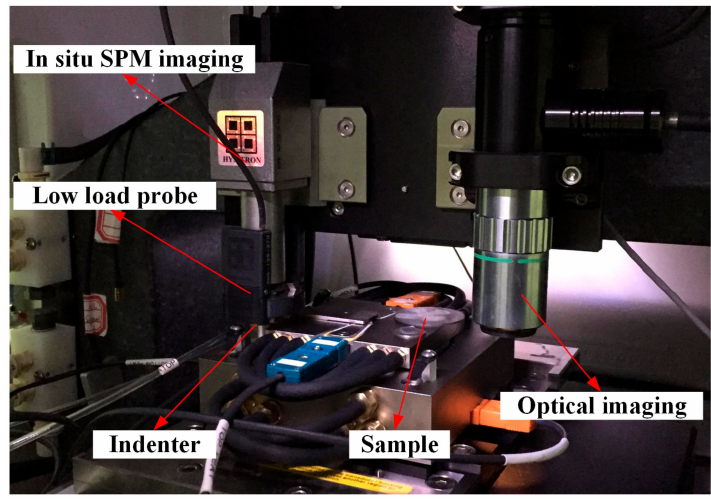
Figure 2. Core component of the TI